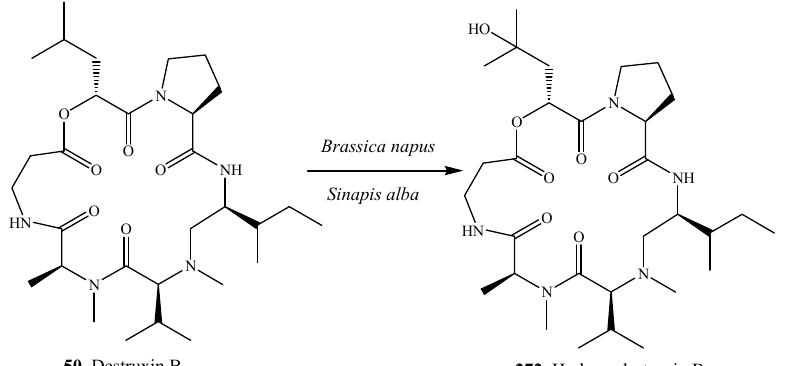
Figure 16. Detoxification pathway of the phytotoxins destruxin B ( 50 ) and homodestruxin B ( 51 ) by the hosts Brassica napus and Sinapis alba